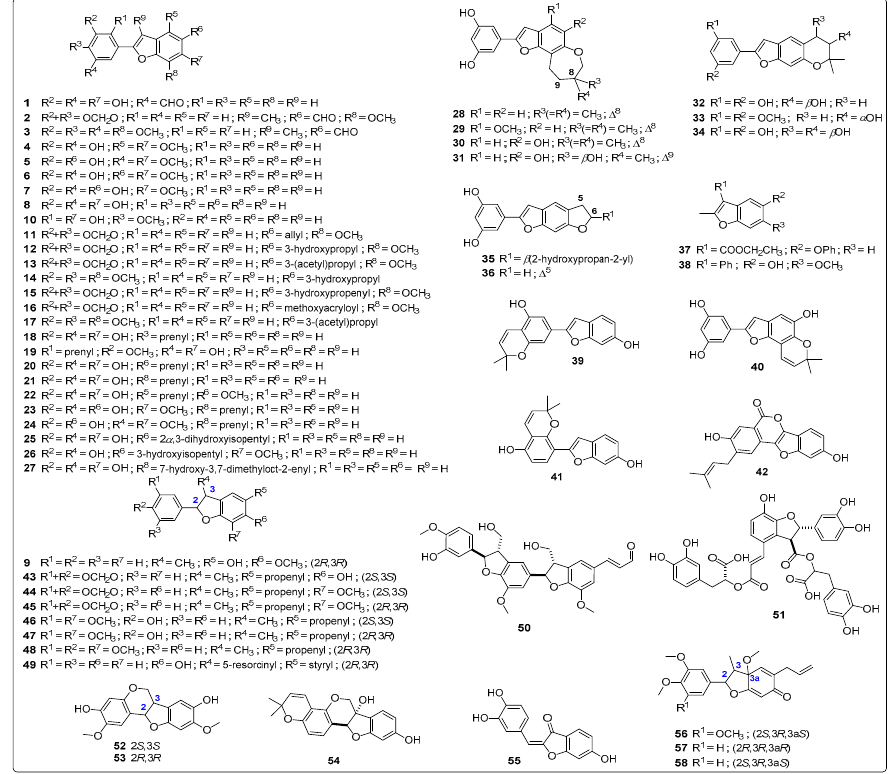
Figure A2. Structures of the test 2-arylbenzofuran-related compounds.